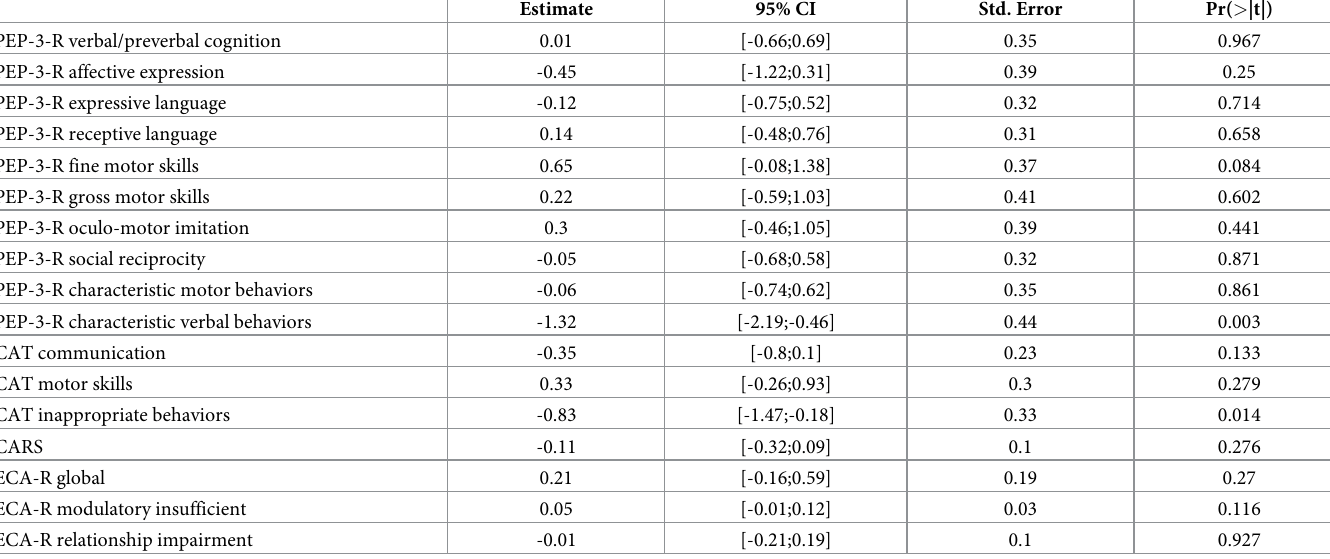
Table 4. Evolution throughout the 12 months for all children included in the EPIGRAM study according to their immigrant status (time � migration effect model with interaction).